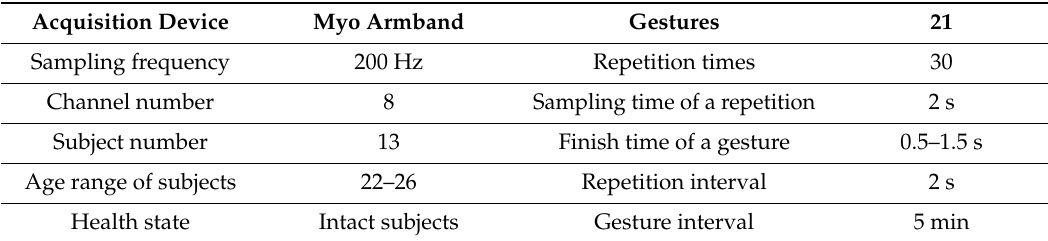
Table 1. Acquisition configuration summary for the collection of datasets .